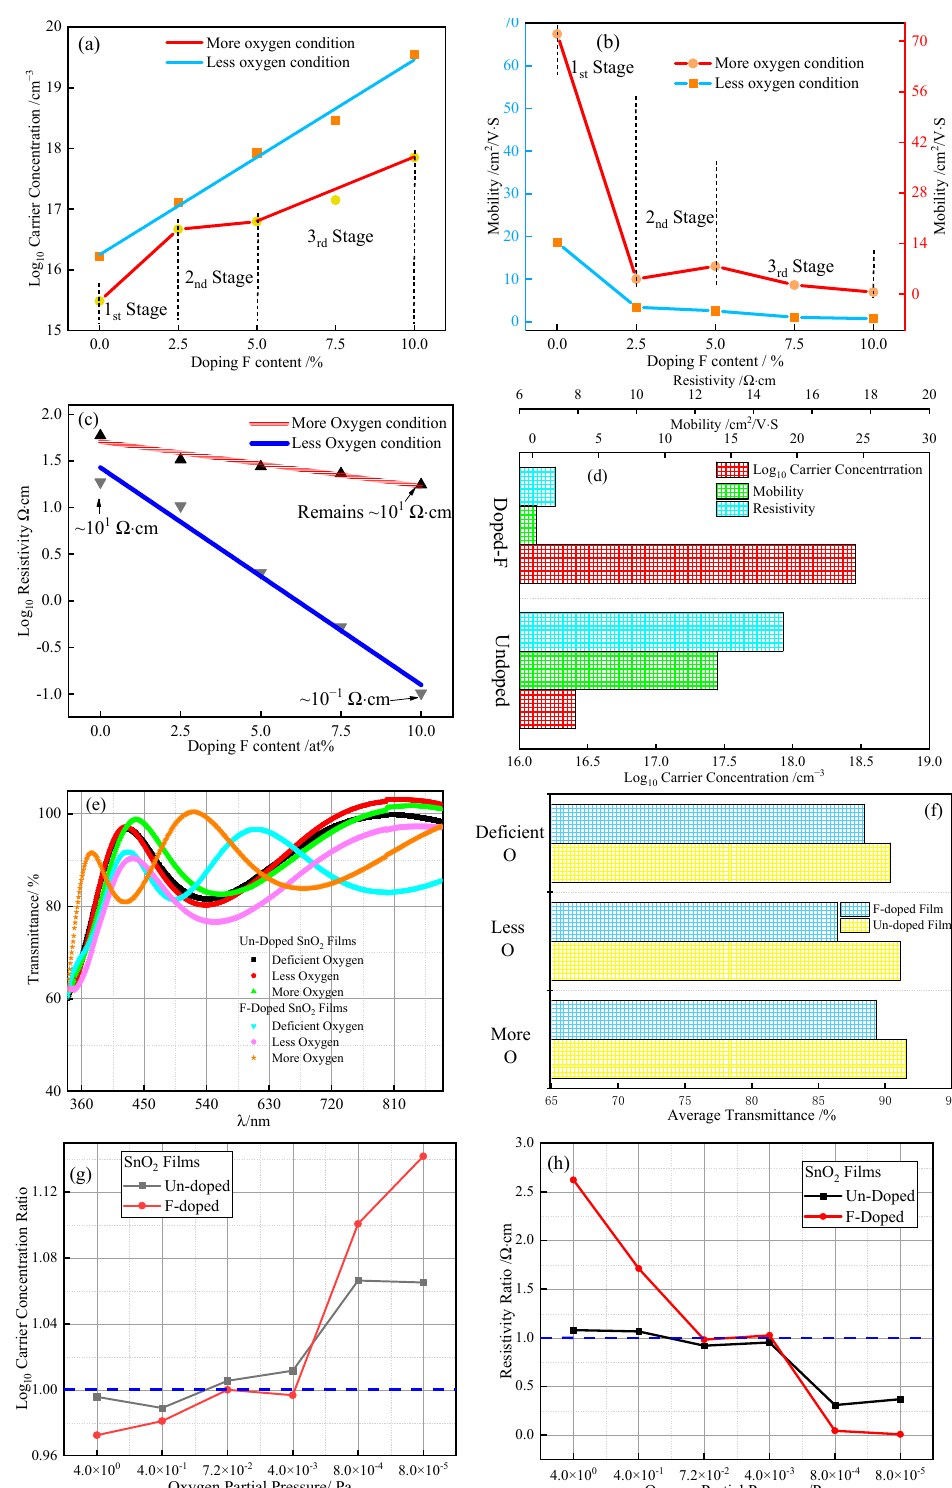
Figure 3. Electrical characteristics of F-doped SnO 2 films grown under more and less oxygen ambient, including carrier concentration ( a ), mobility ( b ) and resistivity ( c ); electrical characteristics ( d ) of F-doped SnO 2 films grown under oxygen-deficient ambient; transmittance curve ( e ) and average transmittance ( f ) of F-doped SnO 2 films grown under different oxygen ambient; the ratio of electrical characteristics of F-doped SnO 2 films, containing carrier concentration ( g ) and resistivity ( h ).